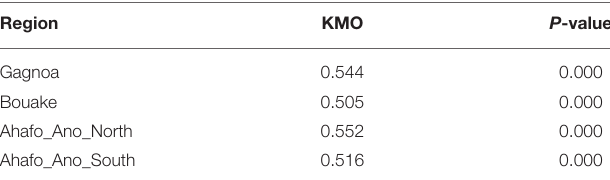
TABLE 4 | Result of the KMO